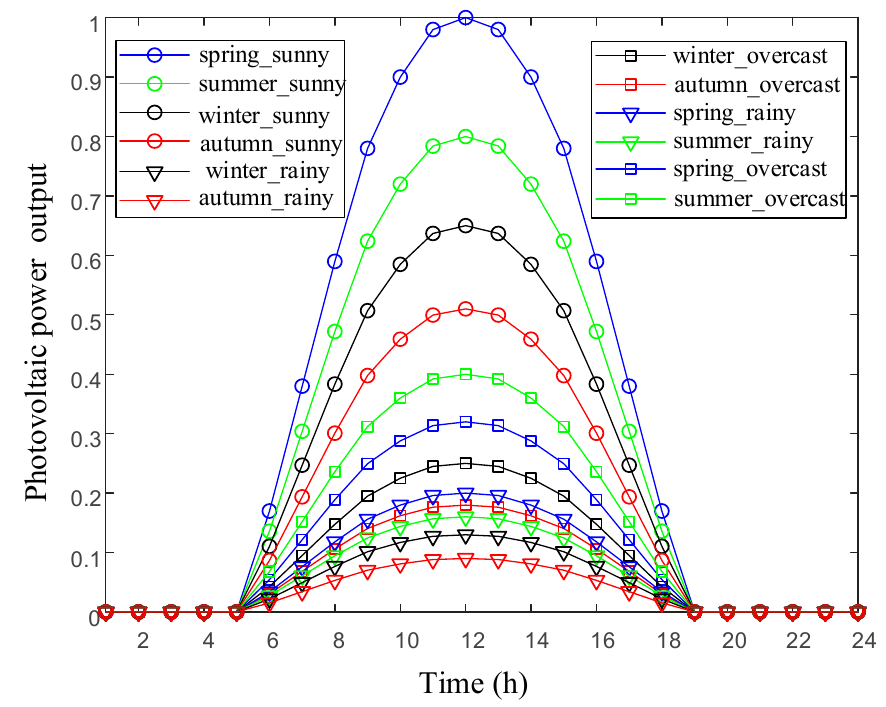
Figure 6. Output curve of photovoltaic.